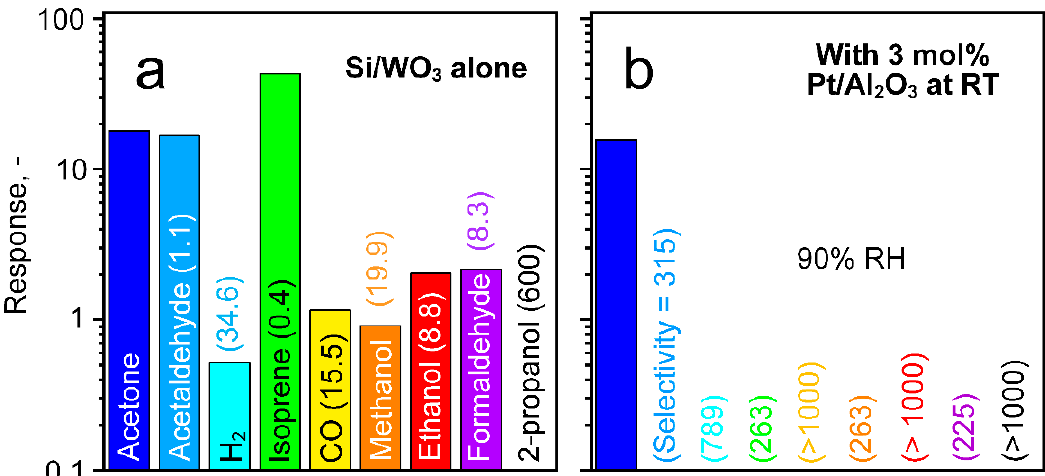
Figure 5. Response of a Si/WO 3 sensor to 1 ppm acetone, acetaldehyde, H 2 , isoprene, CO, methanol, ethanol, formaldehyde and 2-propanol ( a ) with 30 mg pure Al 2 O 3 (i.e., inactive, Figure 3a) and ( b ) 3 mol% Pt/Al 2 O 3 (i.e., active, Figure 3c) at 40 °C and 90% RH. Acetone selectivity is shown in parentheses. Note the logarithmic ordinate scale.